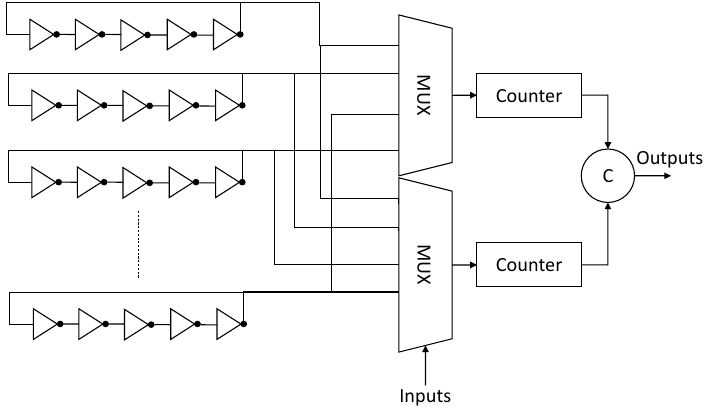
Figure 1. Ring Oscillator Physical Unclonable Function (RO-PUF) general